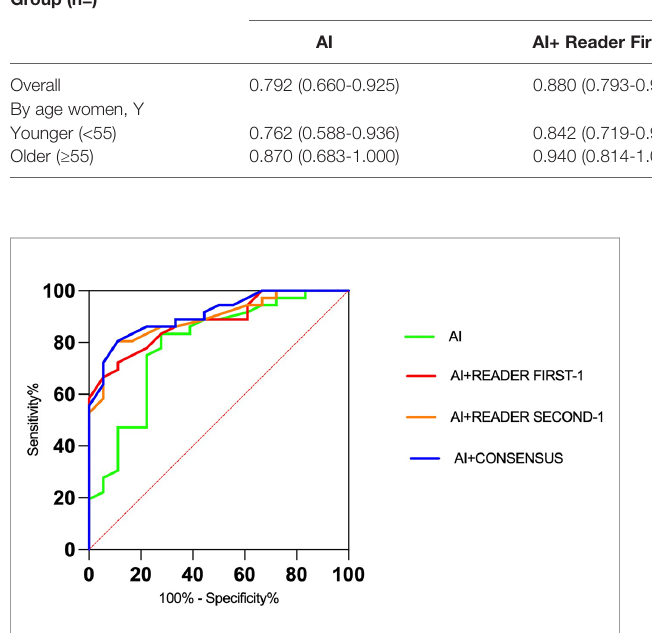
TABLE 4 | Area under the receiver operating characteristic curves for the arti fi cial intelligence algorithms and for algorithms combined with the assessment of the reader fi rst, reader second, and readers consensus. Group (n=)